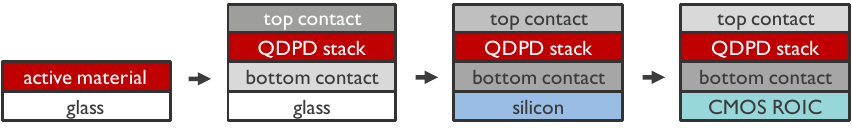
Figure 4. Methodology used for the development of CMOS-compatible QDPD pixel stacks.